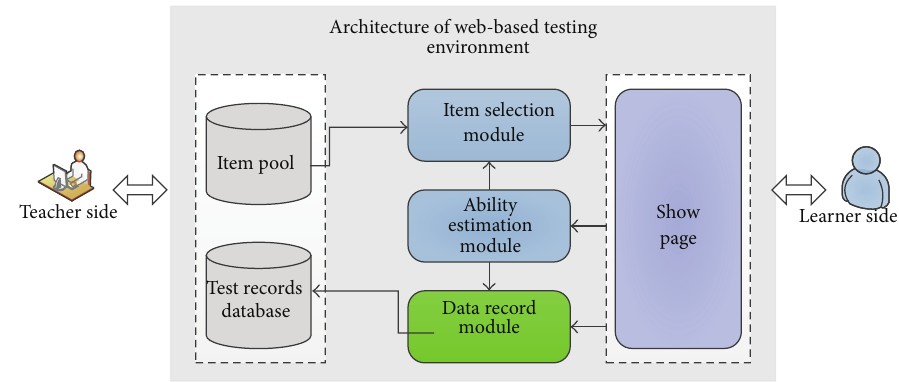
Figure 2: The architecture of web-based testing environment.